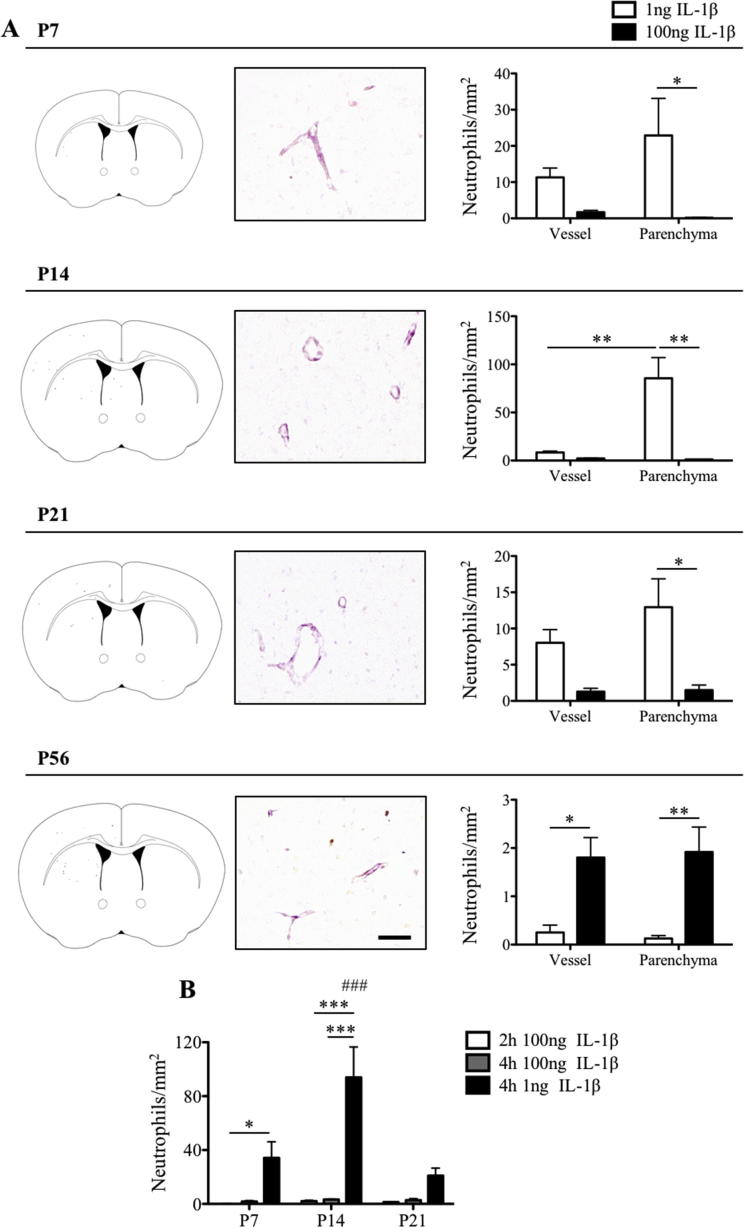
Recruitment of neutrophils to brain parenchyma after intracerebral injection of 100 ng IL-1β during postnatal period. Neutrophil distribution in the brain, shown by representative spatial maps and immunohistochemistry of neutrophils (brown; anti-neutrophil serum) and vessels (pink; laminin), was limited at 4 h following intracerebral injection of 100 ng IL-1β into the striatum at P7, P14, P21 and P56. The number of neutrophils per mm2 of striatum either in the parenchyma or in vessels was significantly lower after the 100 ng IL-1β intracerebral injection compared to the 1ng IL-1β injection at P7, P14, P21. In contrast, at P56, the number of neutrophils was significantly higher following the 100 ng compared to the 1ng dose of IL-1β (A). The absence of the window of susceptibility, observed at 4 h, was also absent at 2 h after intracerebral injection of 100 ng IL-1β at P7, P14 and P21 when compared to the 1ng dose at 4 h (neutrophils per mm2 of striatum after immunohistochemistry using anti-neutrophil serum counterstained with cresyl violet) (B). Scale bar = 50 µm. ∗p < .05, ∗∗p < .01, ∗∗∗p < .001 and ###p < 0.001 vs. all 4 h (h) 1ng values. 4 h — P7: n = 4 each group; P14: n = 5 for 1ng IL-1β, n = 3 for 100 ng IL-1β; P21: n = 4 for 1ng IL-1β, n = 3 for 100 ng IL-1β; P56: n = 3 each group; 2 h - P7: n = 6, P14: n = 6 and P21: n = 5.